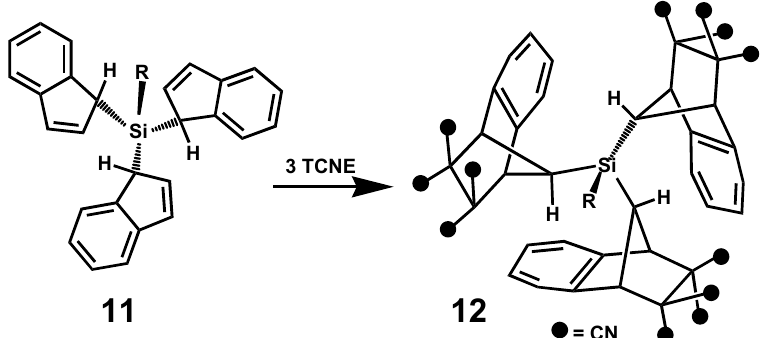
Scheme 7. Multiple Diels–Alder reactions with TCNE to form the triple adduct 12 .